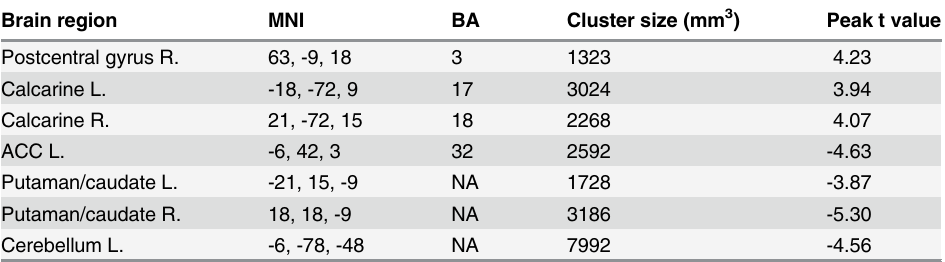
Table 2. Regions showing abnormal amplitude of low-frequency fluctuation in patients.